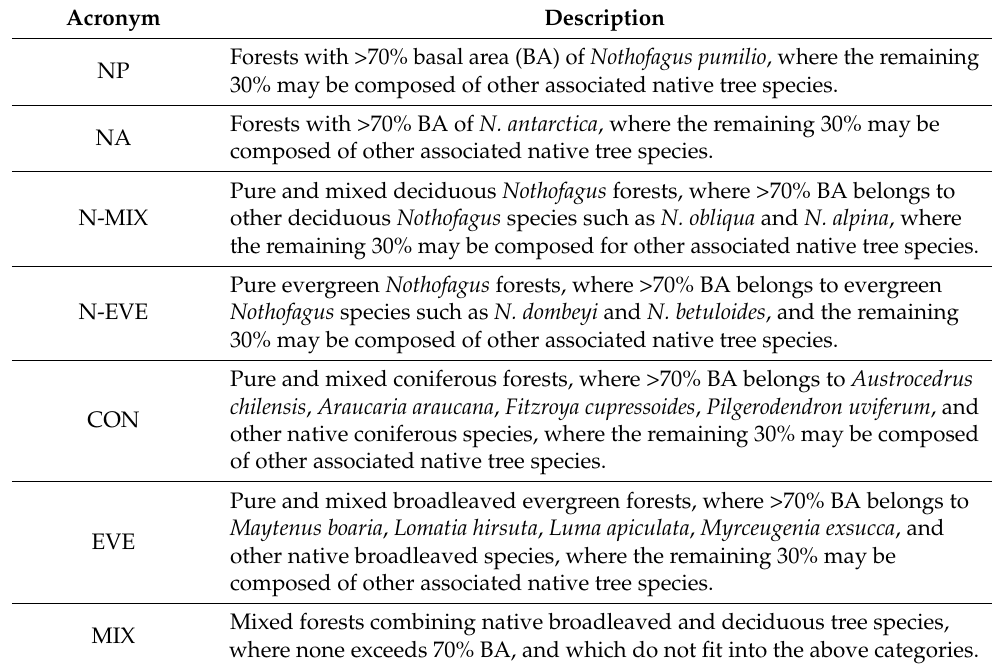
Table 1. Forest type classification for Patagonian